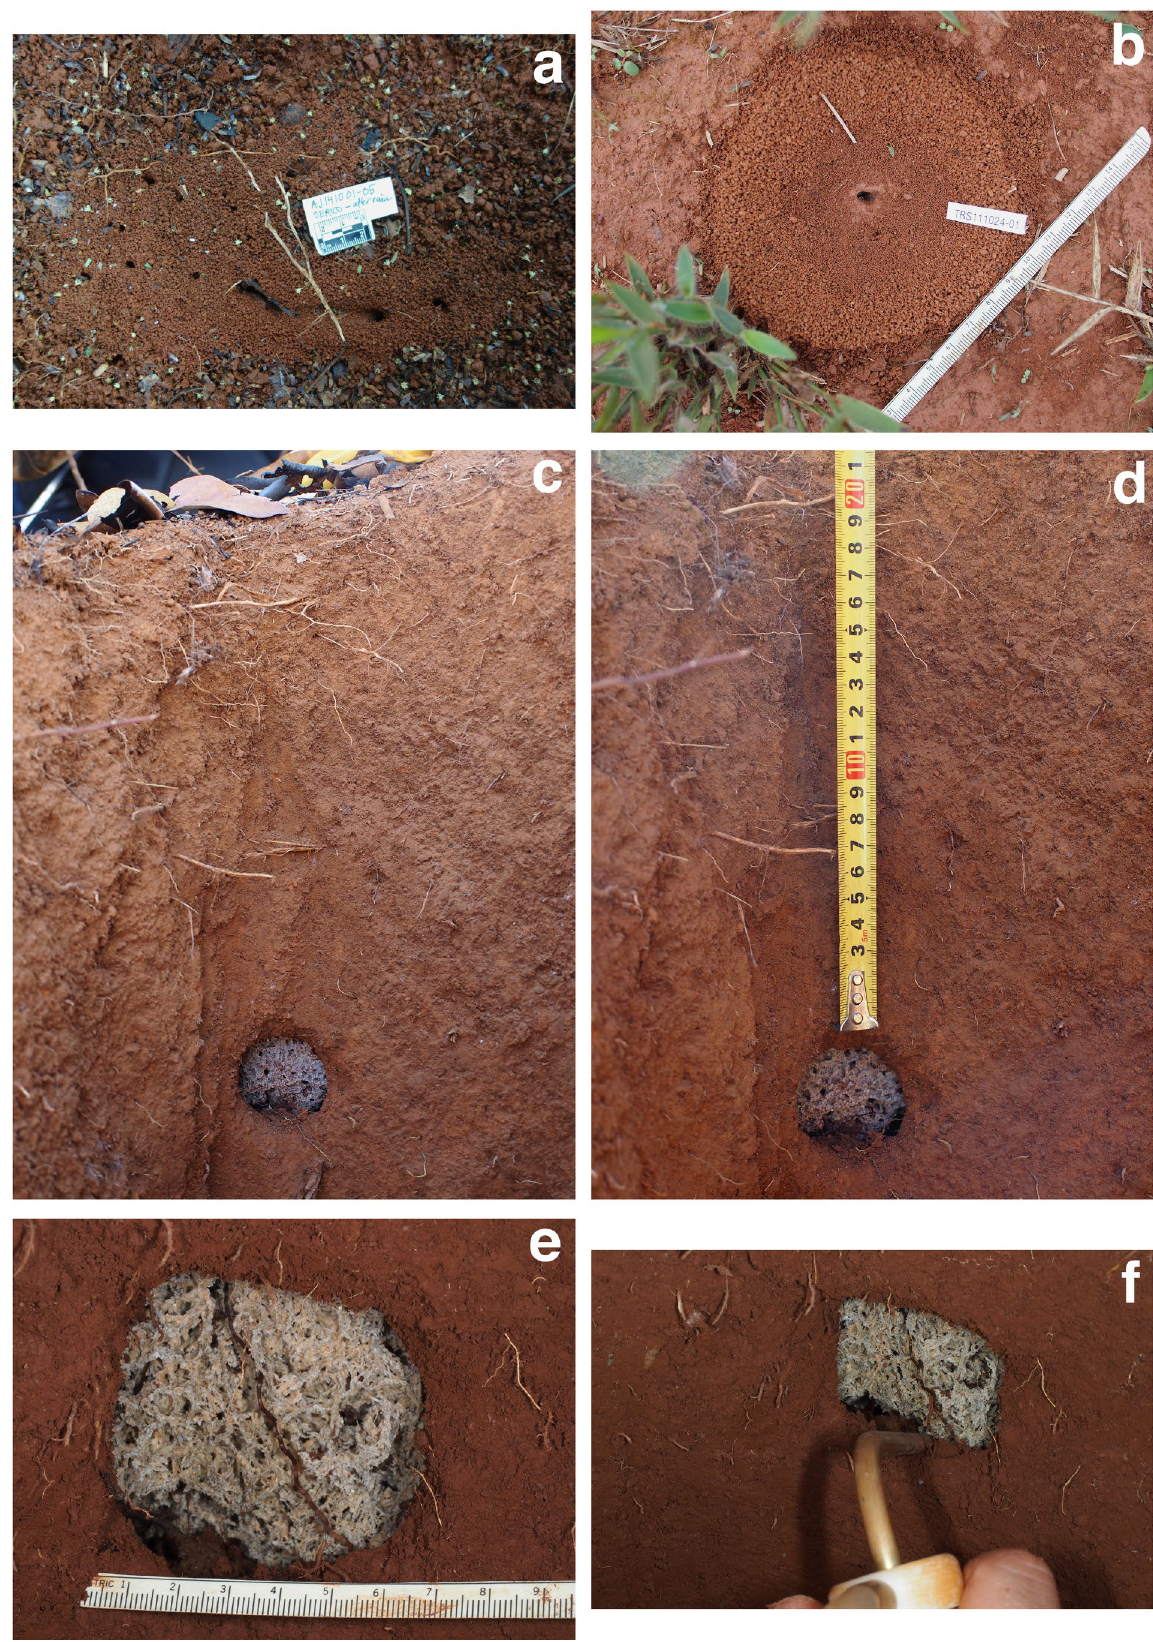
Fig 1. Nests of ground-nesting non-leaf-cutting fungus-farming ants. a. Nest entrance of Sericomyrmex sp. (AJ141001–05) with multiple entrances after rain. b. Nest entrance of Myrmicocrypta sp (TRS111024–01) with small single entrance surrounded by circular dirt mount. c. Subterranean subspherical garden chamber of Myrmicocrypta sp. d. Subterranean garden chamber of Myrmicocrypta sp. with depth record (see text). e. Subterranean chamber of Apterostigma sp. f. Subterranean chamber of Apterostigma sp. demonstrating collection of ants with receptacle